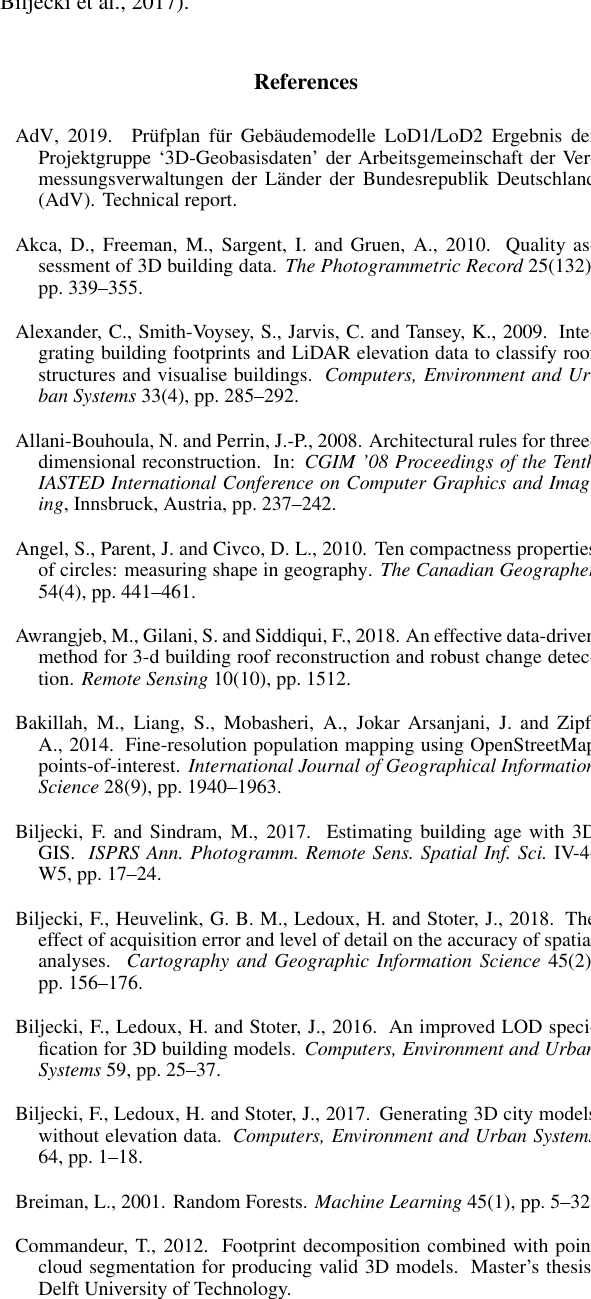
Figure 10. Proposed pipeline from LoD0 footprints to LoD2 models without aerial survey measurements. For previous work (inferring heights of buildings from footprints, generating LoD1 models) see (Biljecki et al., 2017).